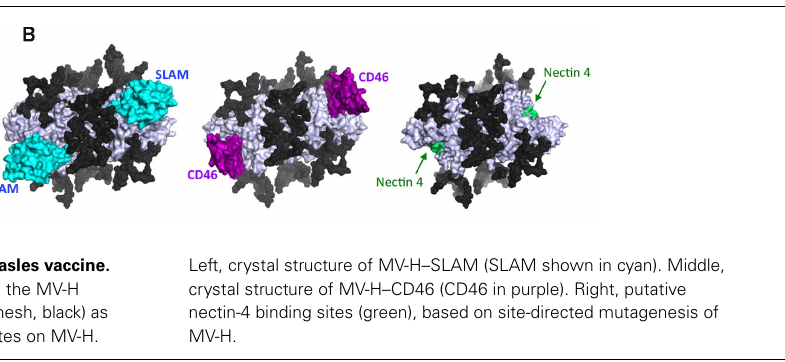
FIGURE 2 | Structural basis of the effectiveness of measles vaccine. (A) Epitopes of anti-MV-H monoclonal antibodies (red) on the MV-H homodimer (blue white) with potential N-linked sugars (mesh, black) as viewed downwards from the top. (B) Receptor-binding sites on MV-H.